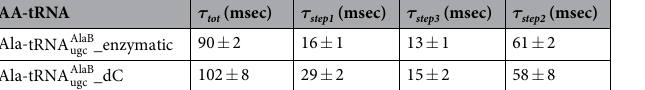
Table 2. Kinetic parameters for fMAF tripeptide formation (see Fig. 4). Mean values were calculated from at least two independent experimental results with their propagated standard deviations.